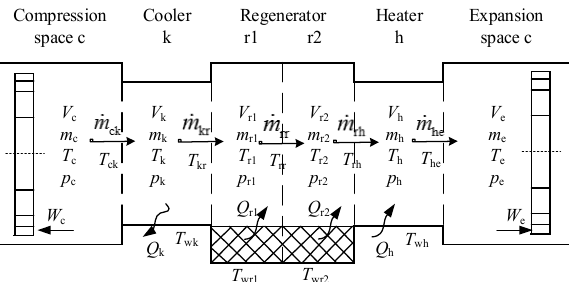
Figure 2. Schematic model of the engine and various temperature distributions.